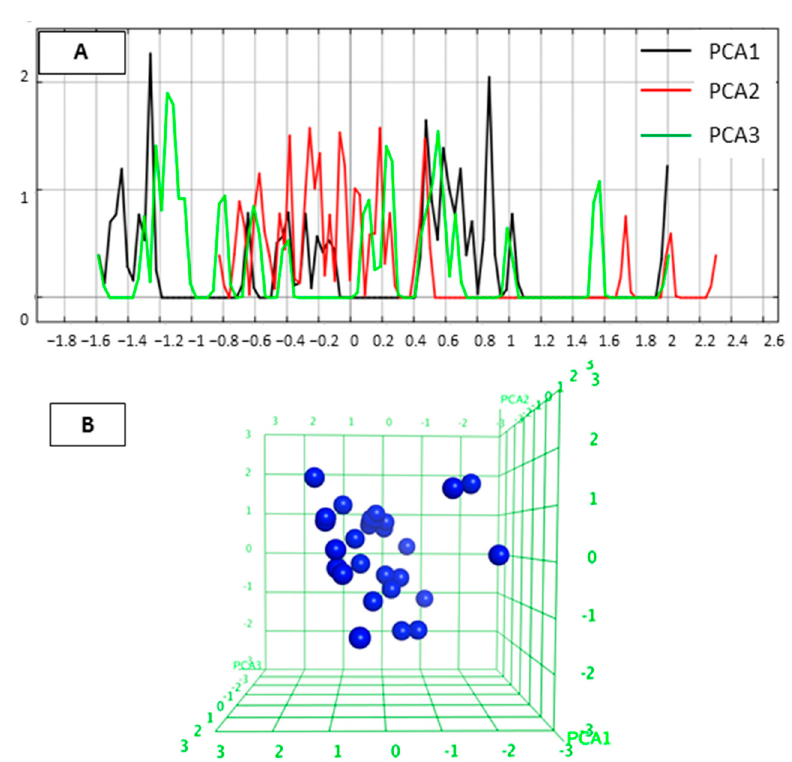
Figure 1. ( A ) 2D plots for visualization of the variation of three most important PCA in test set. Black color represents PCA1, red color PCA2 and green color PCA3. ( B ) 3D plot of the chemical space occupied by the training set (blue).